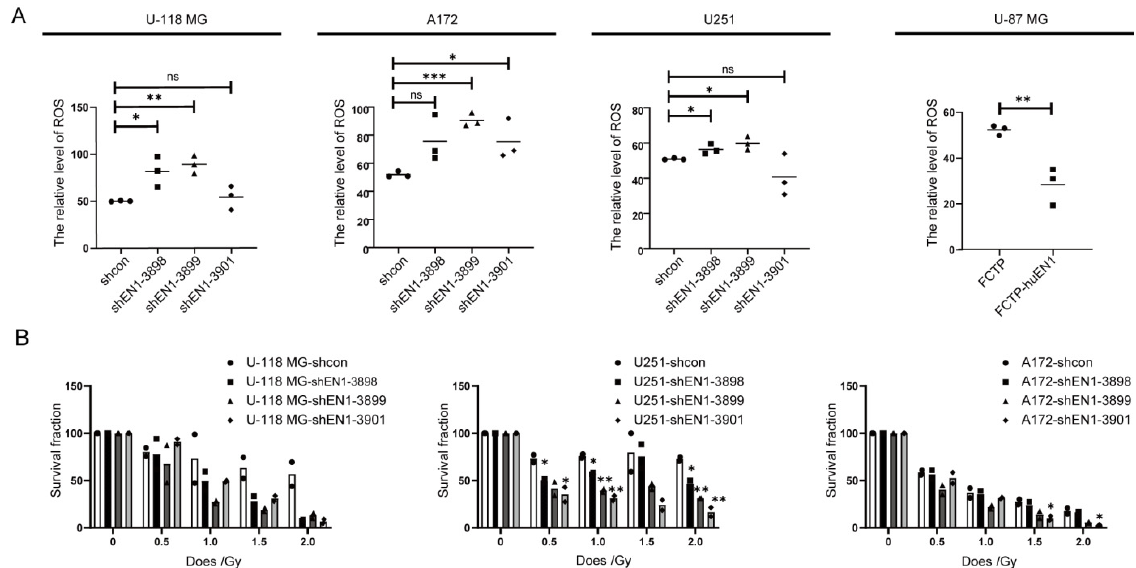
Figure 3. EN1 knockdown increased intracellular ROS levels and elevated susceptibility to γ -ray irradiation. ( A ) EN1 knockdown elevated the intracellular ROS levels of glioma cells, assessed with H2DCFDA assays ( ● for shcon, ■ for shEN1-3898, ▲ for shEN1-3899, ◆ for shEN1-3901).